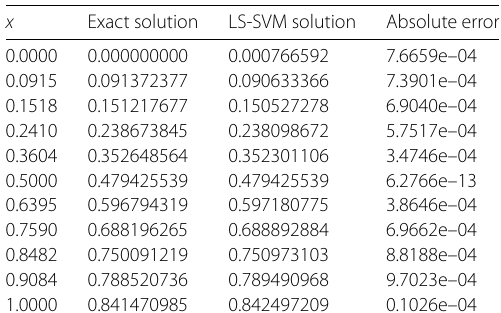
Table 4 Comparison between the exact solution and the LS-SVM solution (Example 4)